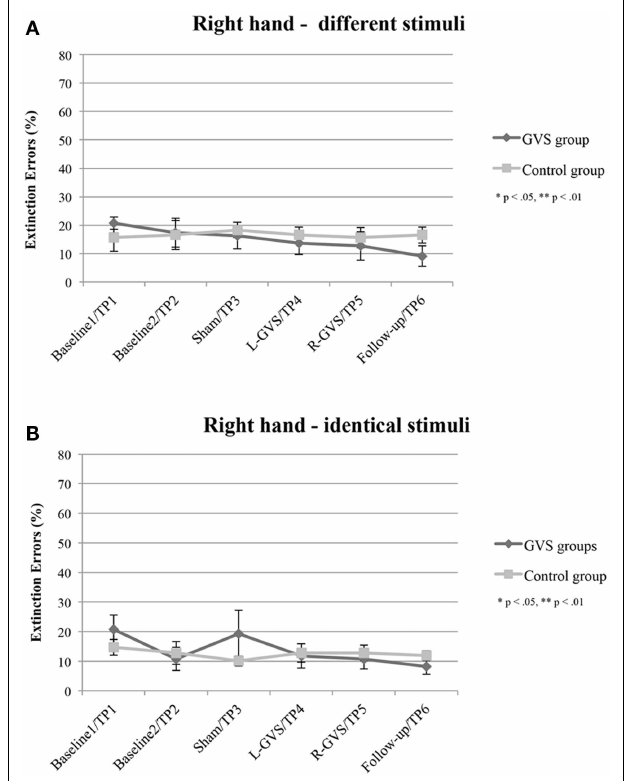
FIGURE 2 | Mean ( ± standard error of the mean) extinction errors (%) for the right-hand in the Quality ExtinctionTest (QET) of the GVS group ( N = 6) and control group ( N = 6) across the six measurement sessions for application of different tactile stimuli (A) and of identical tactile stimuli (B). Note that apart from moderate variations in error rates no significant improvement was observed in the control group due to retesting in six subsequent sessions. Abbreviations: L-GVS, left-cathodal/right-anodal GVS; R-GVS, right-cathodal/left-anodal GVS;